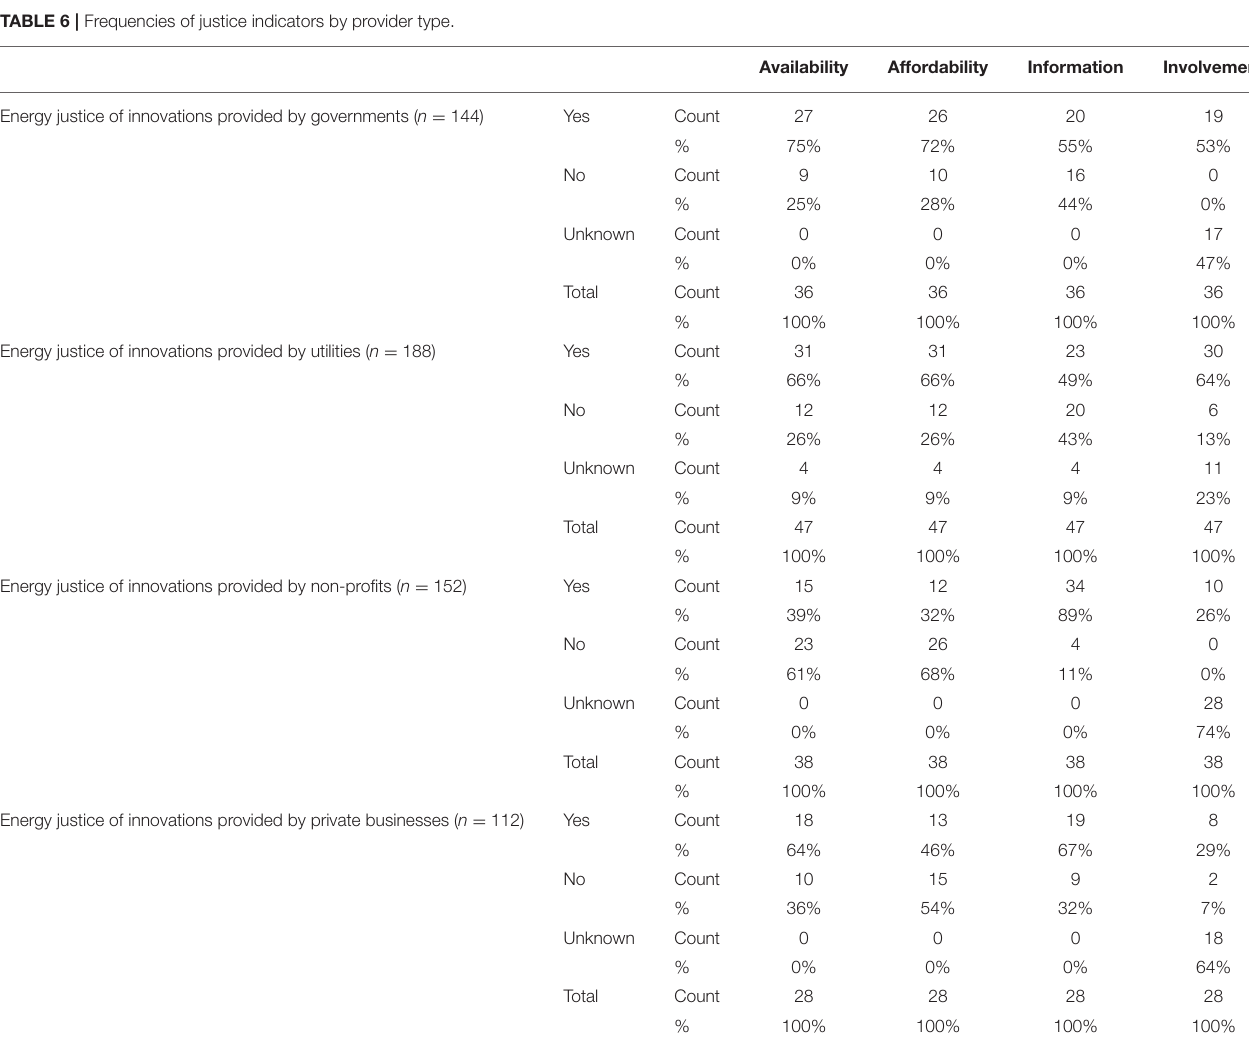
TABLE 6 | Frequencies of justice indicators by provider type.